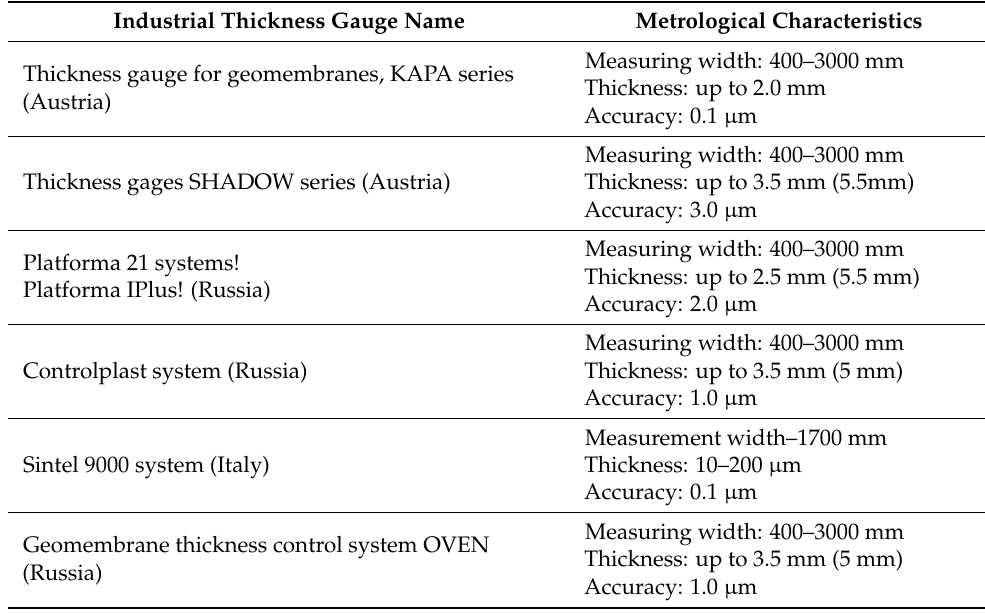
Table 1. Characteristics of measuring systems.